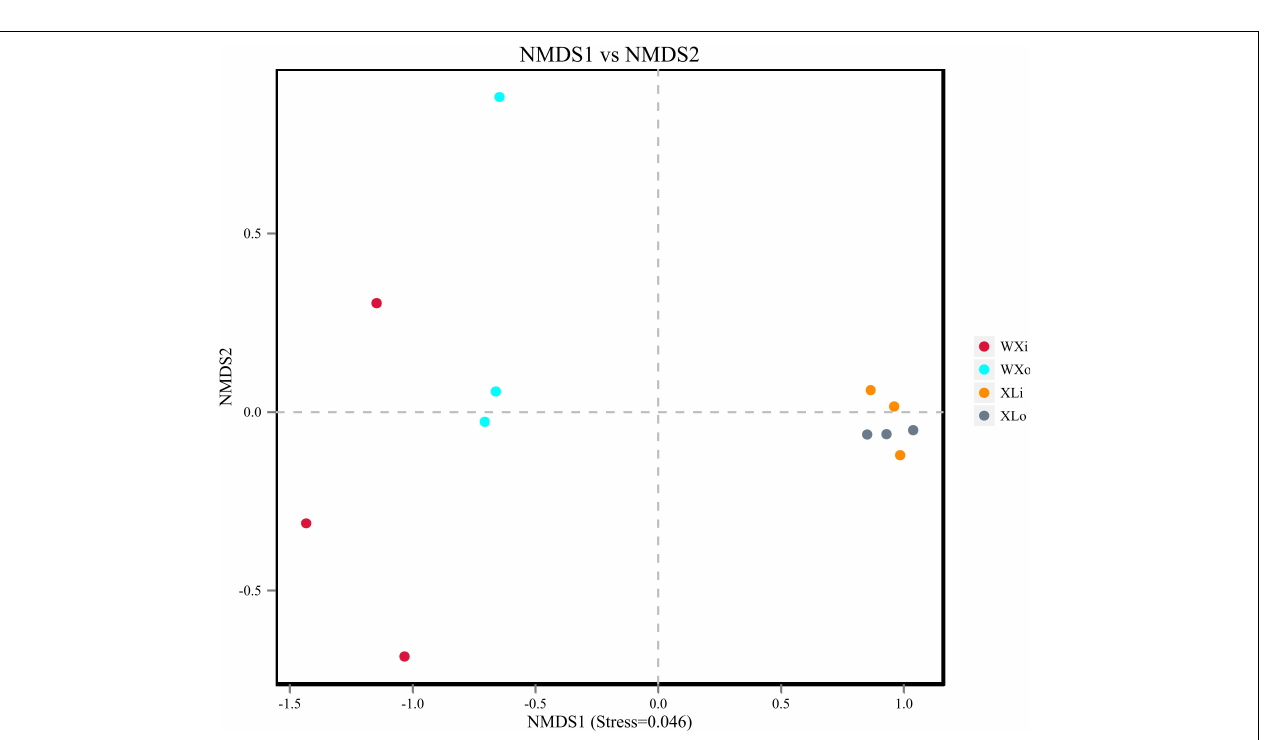
FIGURE 5 | The beta diversity results of NMDS indicating the data distribution of doushen